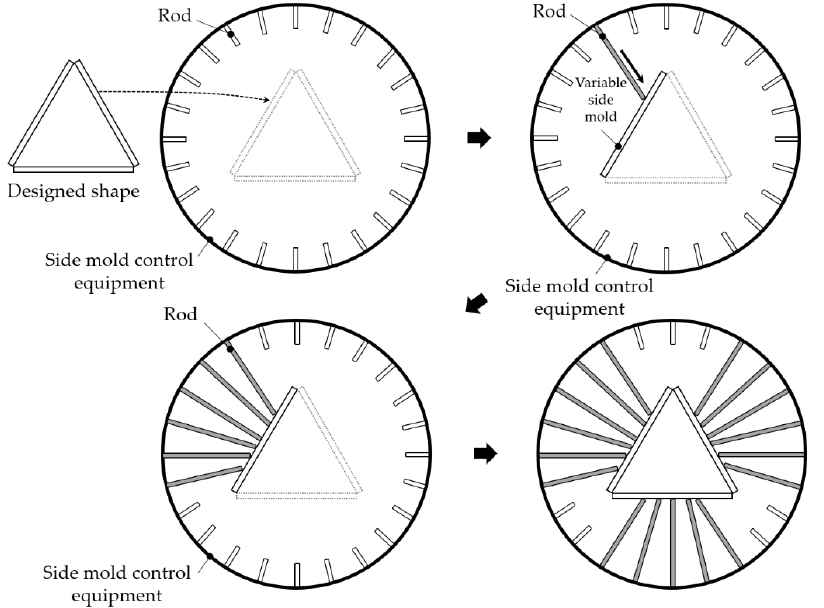
Figure 9. Concept of the side mold equipment.